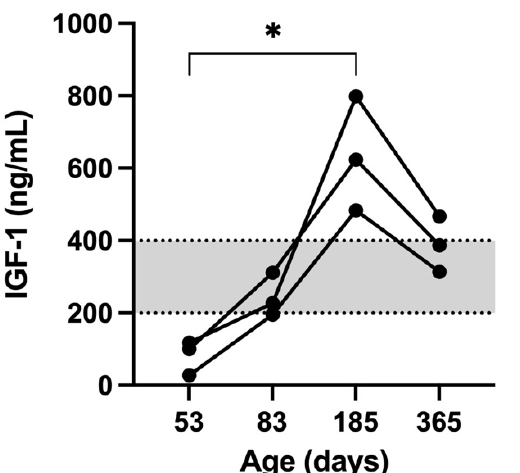
Figure 7. The IGF-1 concentrations (ng/mL) in the 3 kittens at 53, 83, 185, and 365 days of age. The grey area represents the reference range for IGF-1. The * indicates a significant difference ( p < 0.05) in IGF-1 concentrations between 53 and 185 days of age.